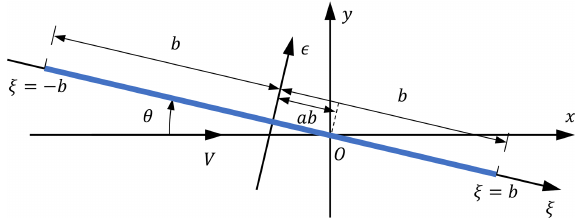
Figure 1. Definitions of the coordinate system and positive direc- tions used in the derivations of the unsteady 2-D thin airfoil theory.